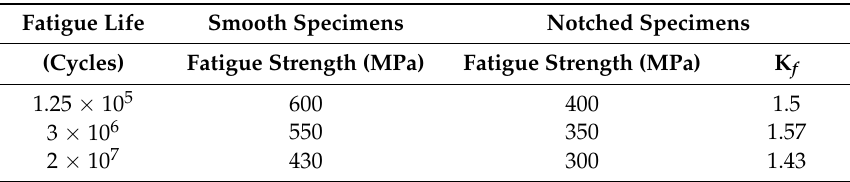
Table 1. Fatigue notch factors in various fatigue lives.